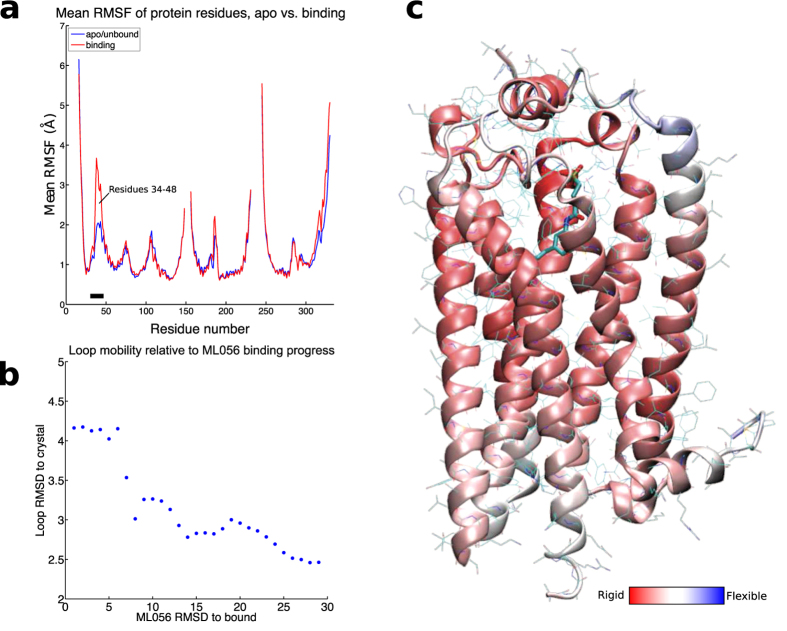
Flexible N-terminal helix allows access during binding.(a) Root mean square fluctuation (RMSF) of each residue of S1P1R. Blue line shows simulations where no ML056 was binding (>15 Å). Red curve shows RMSF for several trajectories during the binding process (<15 Å). A black bar is shown below residue 34–48. (b) RMSD of ML056 to bound versus the RMSD of the loop to its crystal structure. As ML056 binds, the loop becomes increasingly disordered. (c) S1P1R in cartoon representation colored by crystallographic B factor (a.k.a. temperature factor). Dark Red indicates rigid structure, dark blue indicates greater flexibility. Notably the N-terminal helix over the entrance is the most flexible part of the structure.